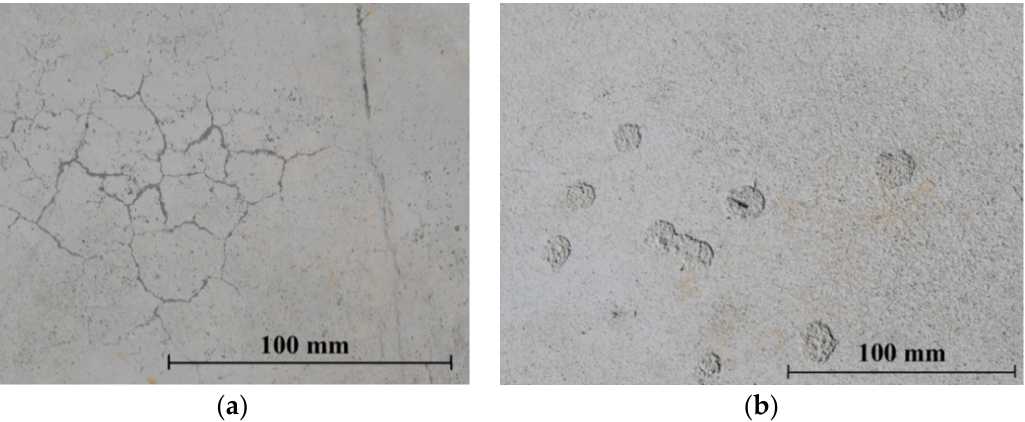
Figure 9. Surface-treatment defects: ( a ) cracks (SAC-mix slab); ( b ) chips (SAC/Y-mix slab) (adapted from [23]).